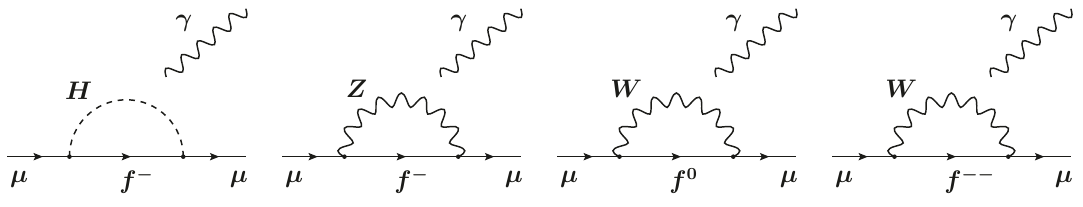
Figure 1. One-loop diagrams that contribute to the muon g (cid:0) 2, where f (cid:0) , f 0 and f (cid:0)(cid:0) are extra leptons, and the photon attaches to charged